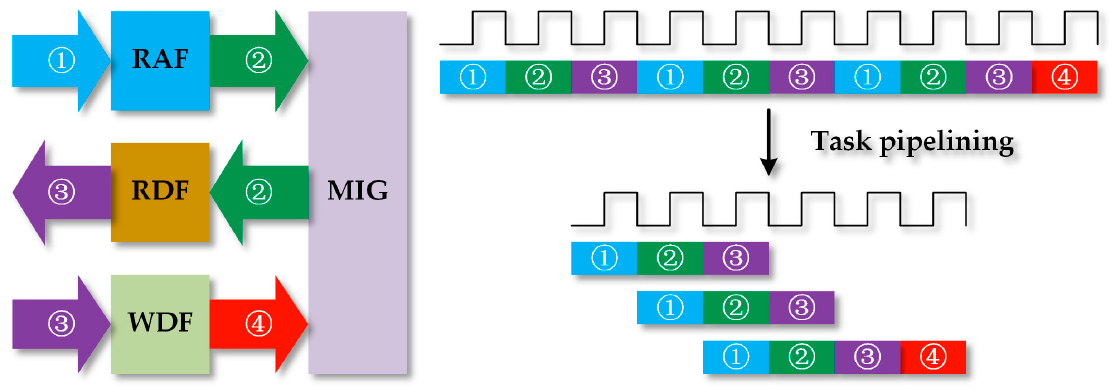
Figure 10. Task pipelining reduces the interval between tasks.